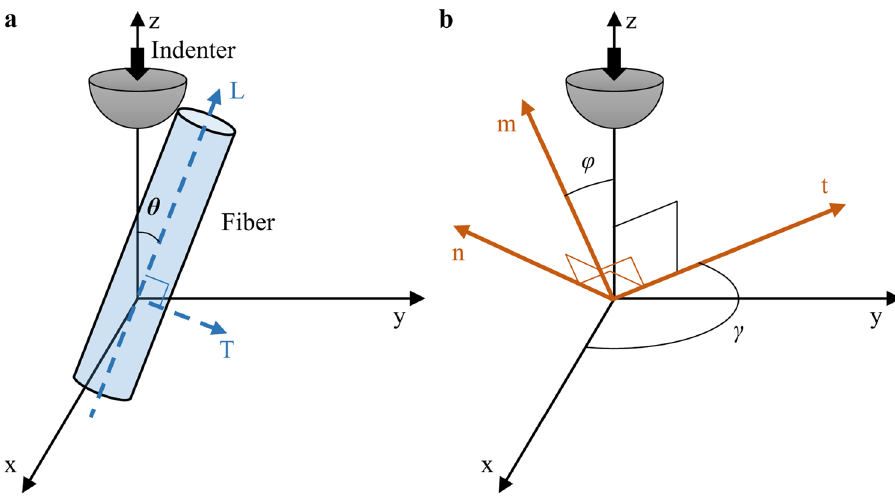
Fig. 1 Coordinate systems for a fiber in blue and b VN model in orange (separated for clarity)